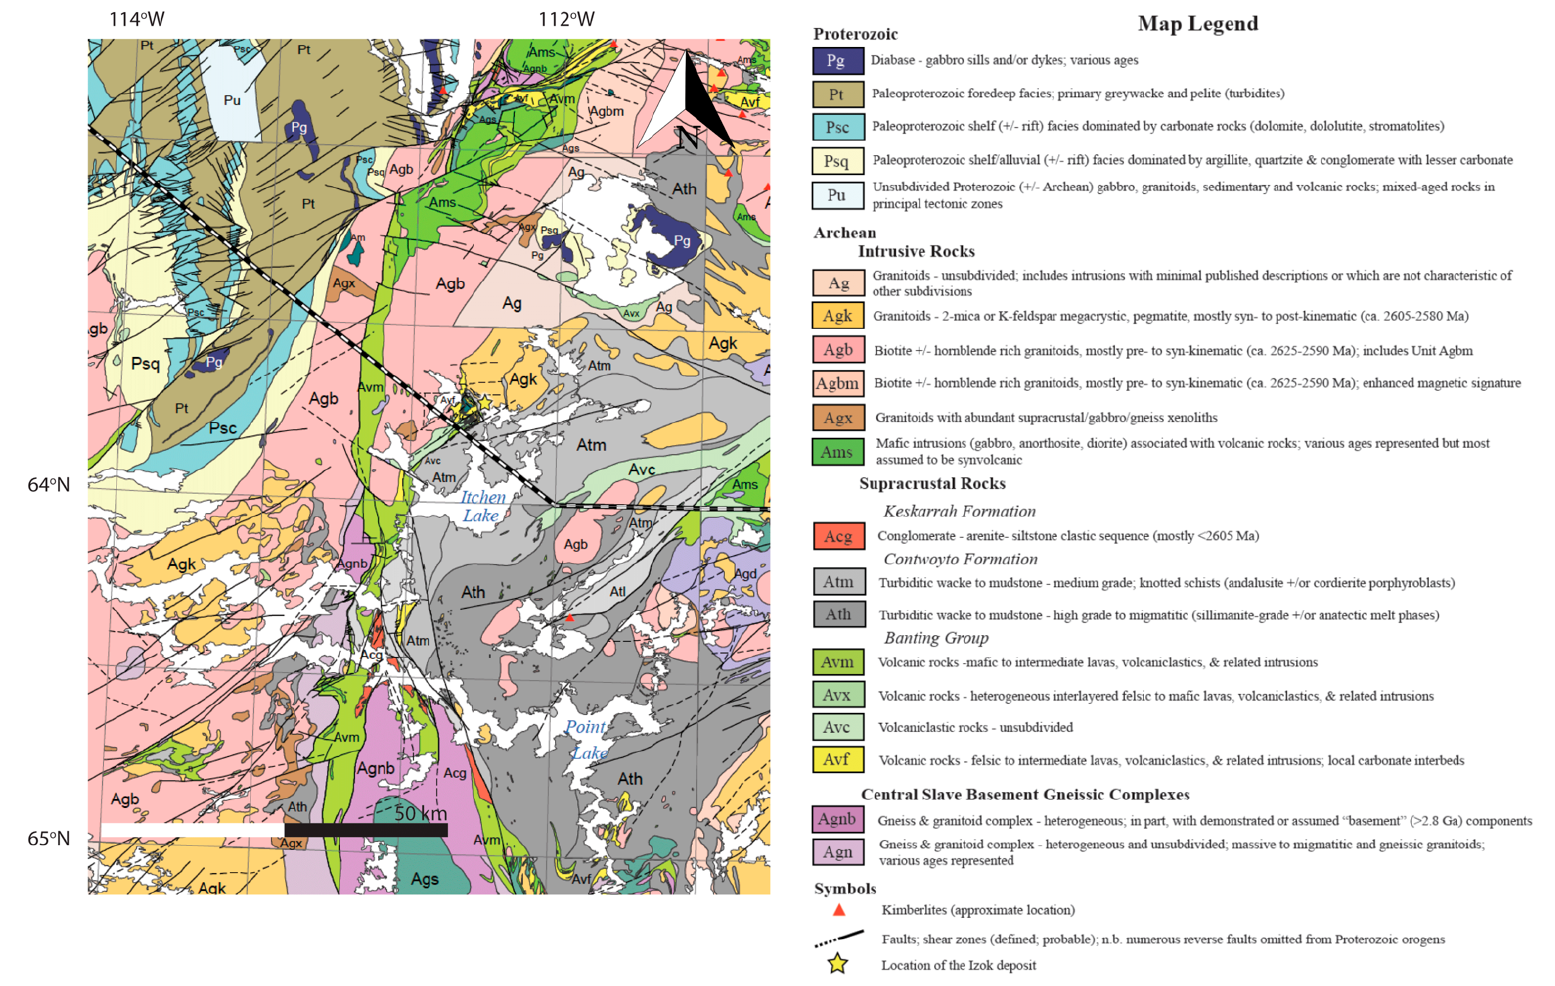
Figure 1. Geological map of the Point Lake belt, northwest Slave Province, Nunavut, Canada. The location of the Izok Lake deposit within the belt is indicated by the yellow star. Heavy black and white dashed line indicates the NWT-Nunavut border. Compiled using map data from Stubley and Irwin [30].